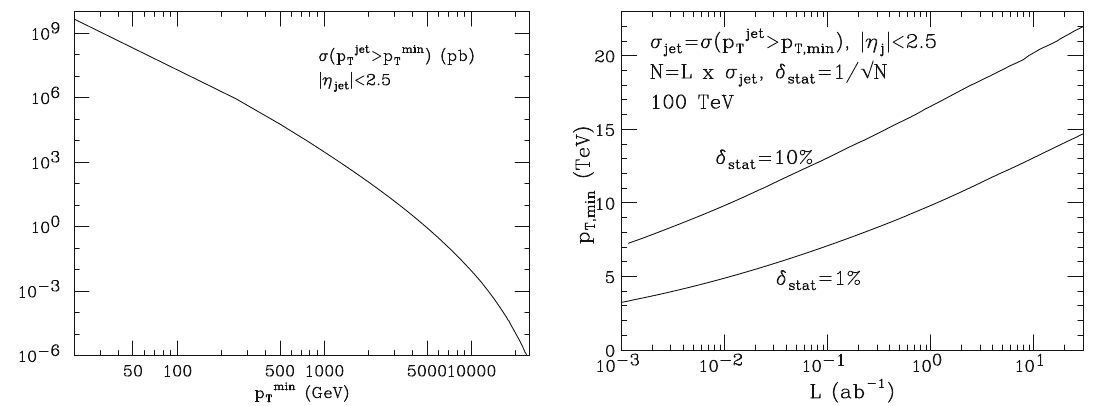
Fig. 5.4 High- p T jet rates (left) and luminosity evolution of the minimum p T thresholds leading to 1 and 10% statistical uncertainties (right)